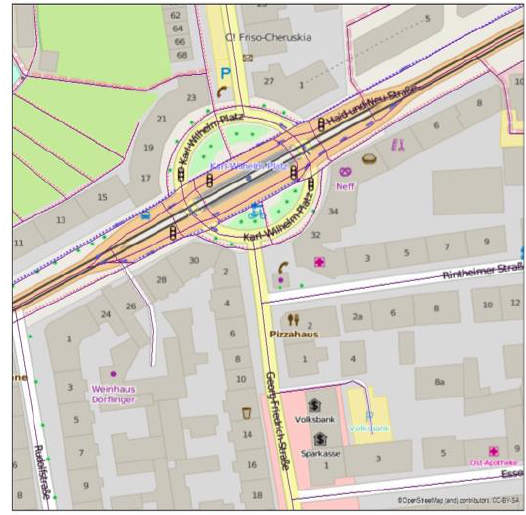
Figure 1. The road centerlines retrieved from OSM and overlaid on the map. The roads are represented with the centerline (violet